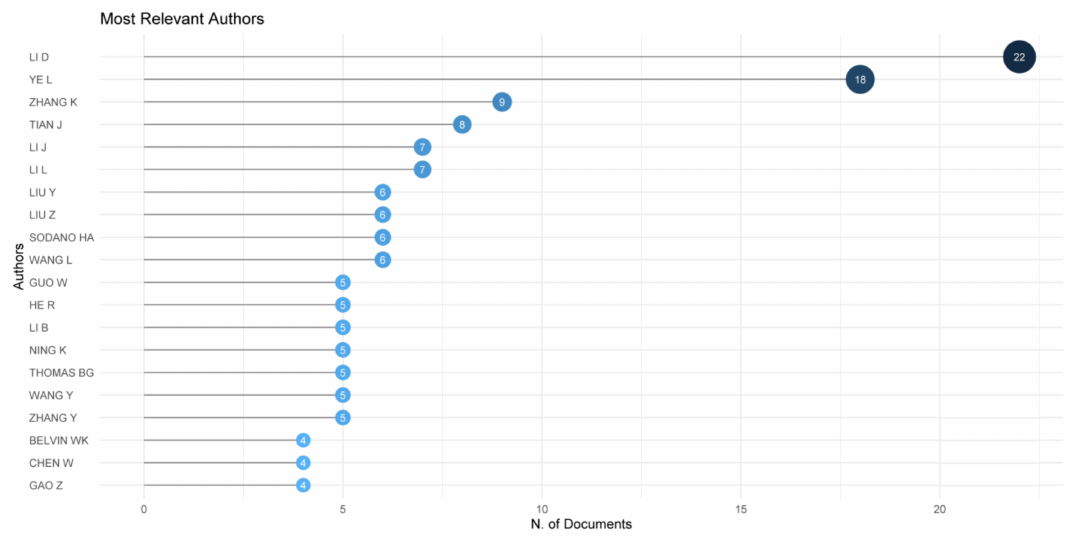
Figure 3. Most relevant authors.